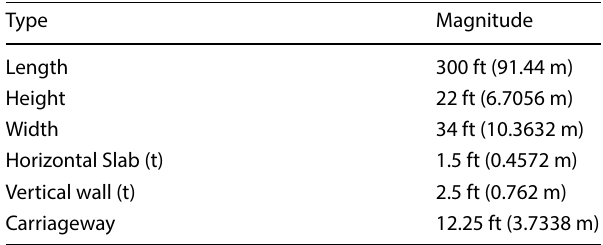
Table 1 Details of SFT Tube